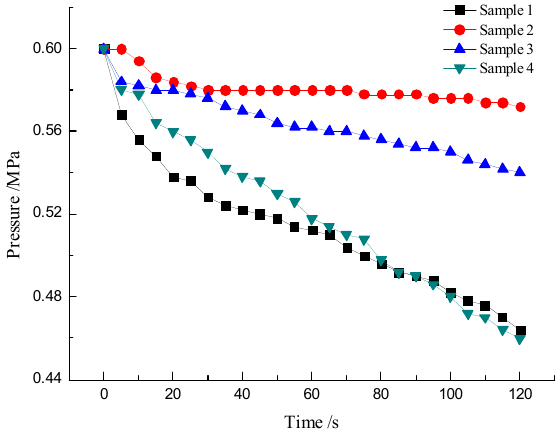
Figure 21. The relationship between the air pressure and time during axial stretching.